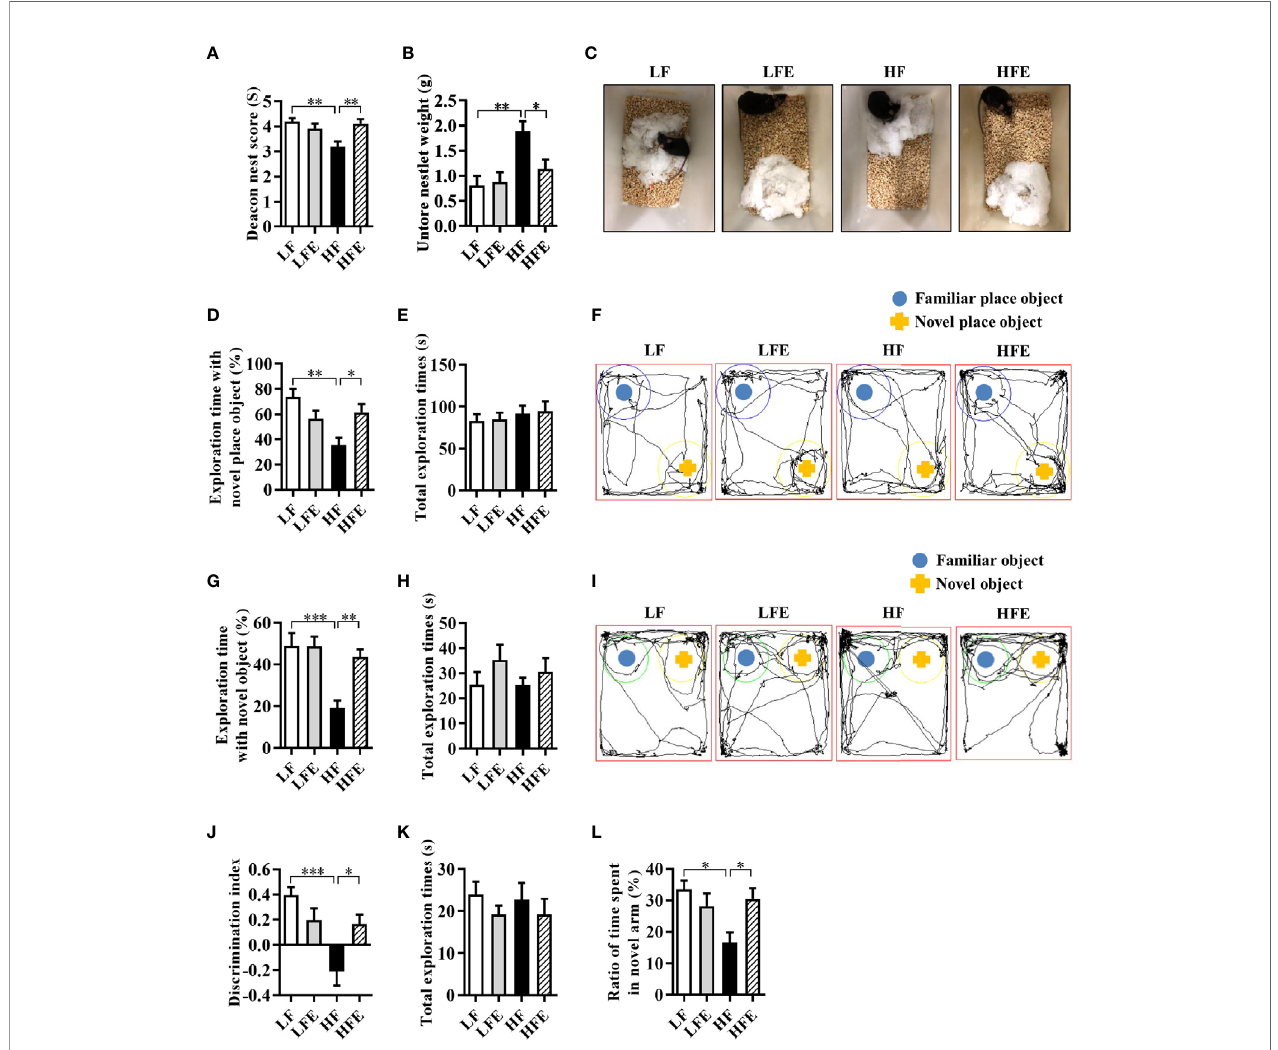
FIGURE 1 | ESPs supplementation prevented cognitive impairment in HF diet-induced obese mice. The nest building test was used to assess the activities of daily living of mice (A – C) . (A) The nest score and (B) untore nestlet weight (amount of untore nesting material). (C) Representative nest results of the low-fat (LF), ESPs supplementation in LF (LFE), high fat (HF), and ESP supplementation in HF (HFE) groups. The object location test was performed to evaluate the spatial memory of mice (D – F) . (D) Percentage of time spent with the object in the novel place to the total object exploration time. (E) The total object exploration time. (F)